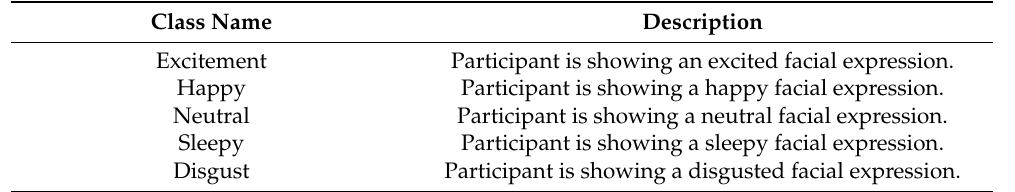
Table 3. Emotion classes for image